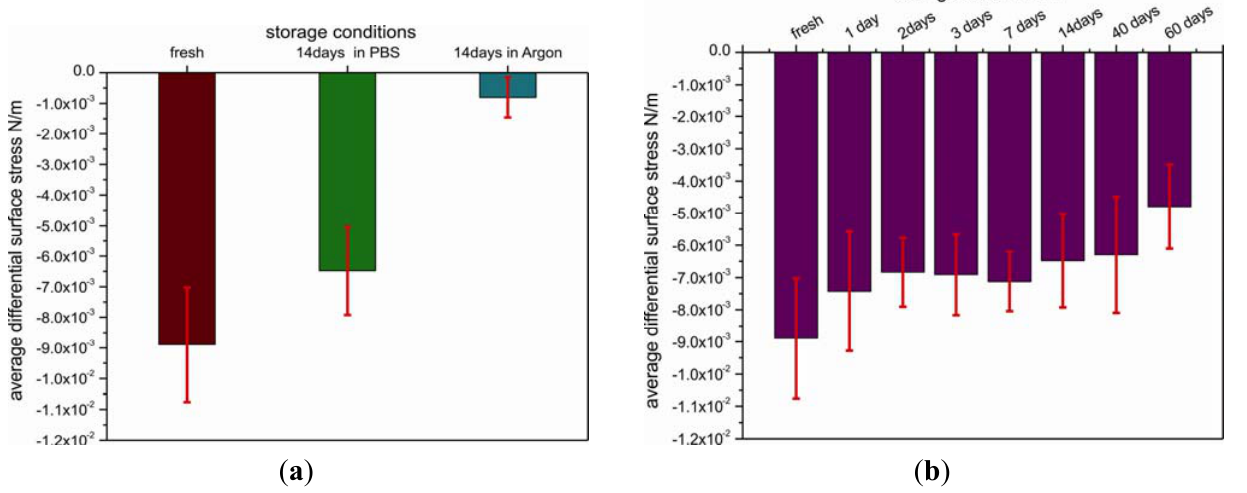
Figure 3. Bar graphs showing the stability of the pre-functionalized biosensor arrays. Each bar represents the average of differential surface stress with standard deviations produced by the response to 1.5µM of NeutrAvidin. ( a ) Stability in various storage environments. ( b ) shelf-life graph for different storage durations in